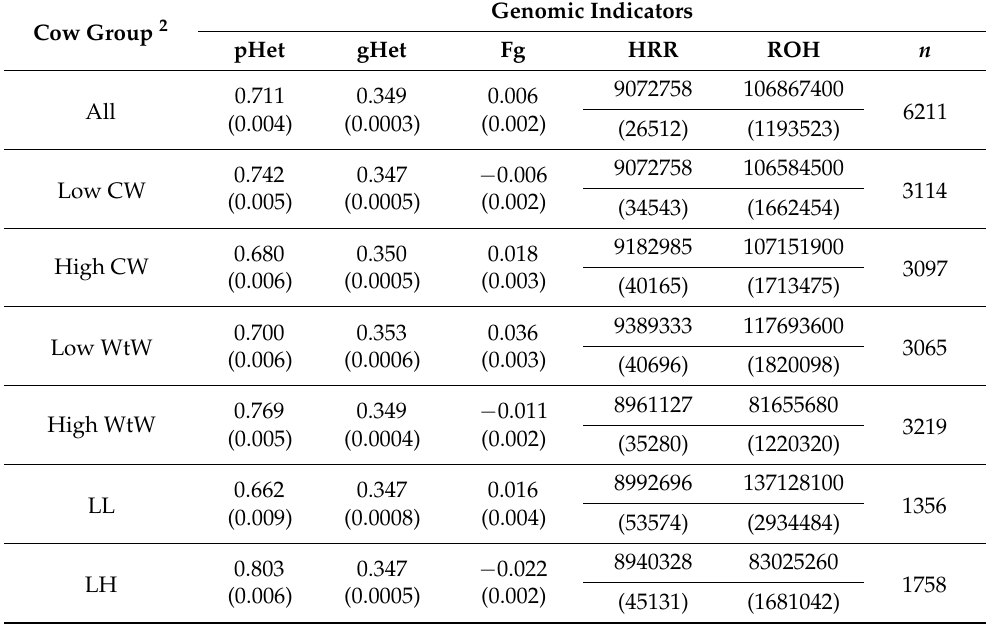
Table 4. Means (SE) of pedigree-based retained heterozygosity (pHet) and genomic indicators of heterosis 1 for cows grouped by projected effects on cow weight (CW) and cumulative weight weaned (WtW). Cow Group